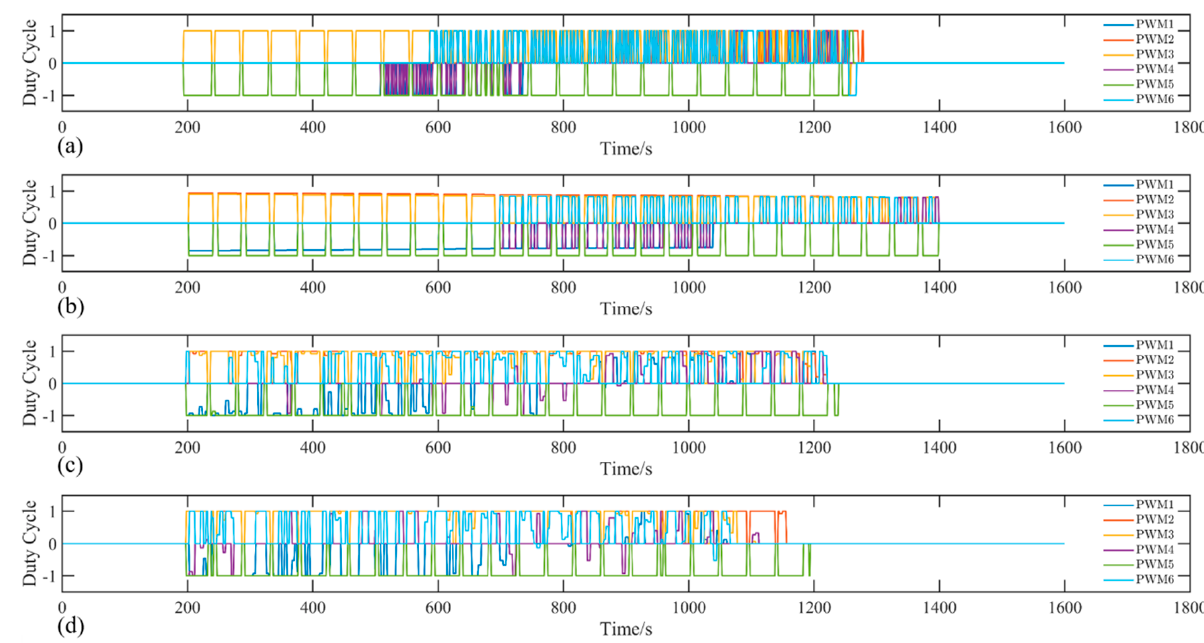
Figure 12. Balancing current: ( a ) FDC; ( b ) VDC; ( c ) GPC. ( d ) VSSGPC.